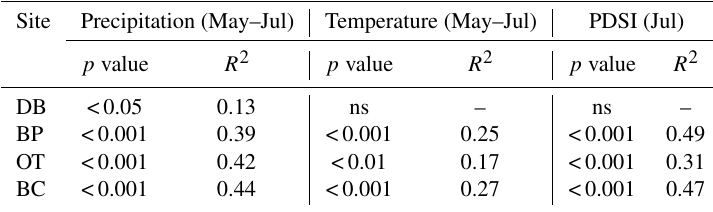
Table 5. Relationships between ARSTAN ring width index and midgrowing season climatic conditions ( α = 0 . 05). Note: Palmer drought severity index – PDSI; statistically non-significant relationships – ns.